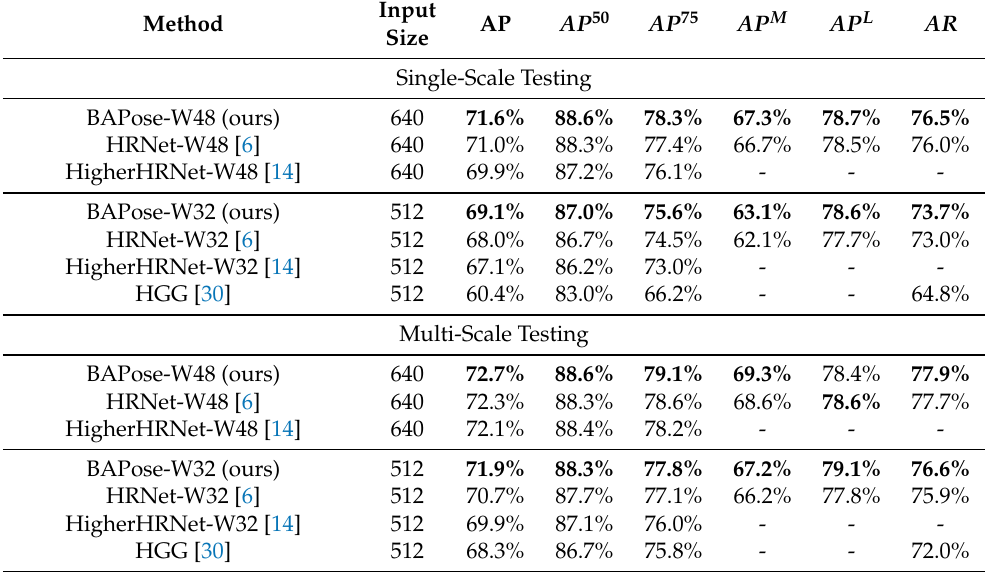
Table 2. BAPose results and comparison with SOTA methods for the COCO dataset for validation. Best results are in bold.